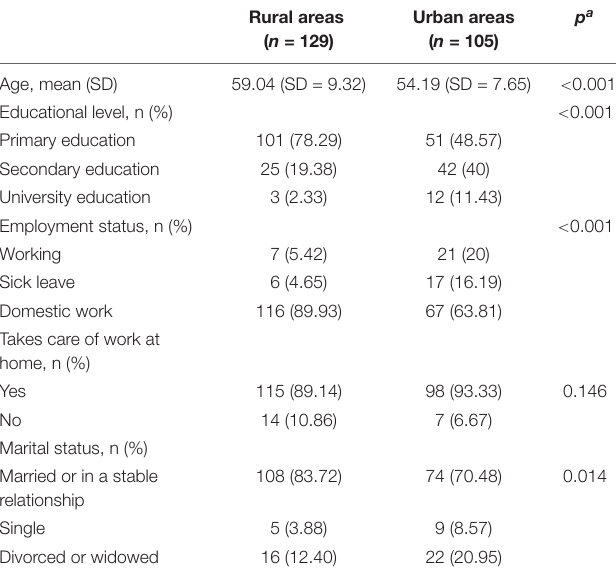
TABLE 1 | Differences in sociodemographic variables between the rural area and the urban area group.